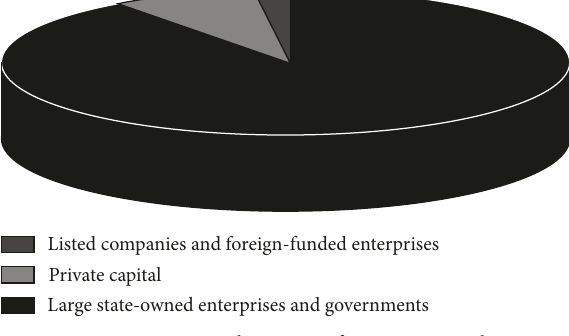
Figure 2: Capital sources of venture